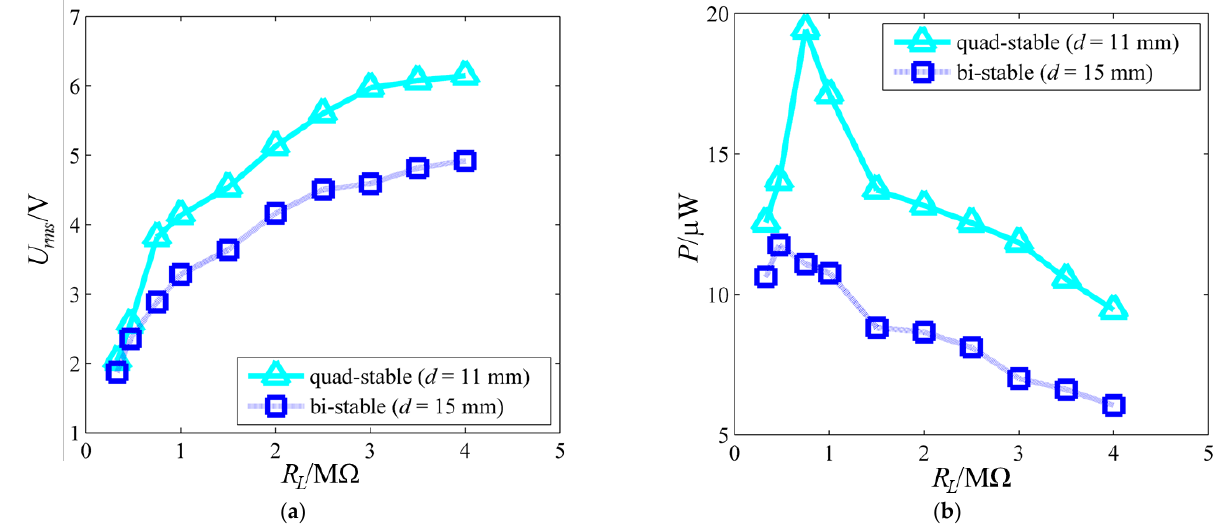
Figure 11. Experimental voltage and power variation with resistance load R L under the quad-stable structural parameters when a Arms = 1.49 g and the bi-stable structural parameters when a Arms = 1.56 g: ( a ) U rms − R L curves; ( b ) P − R L curves.